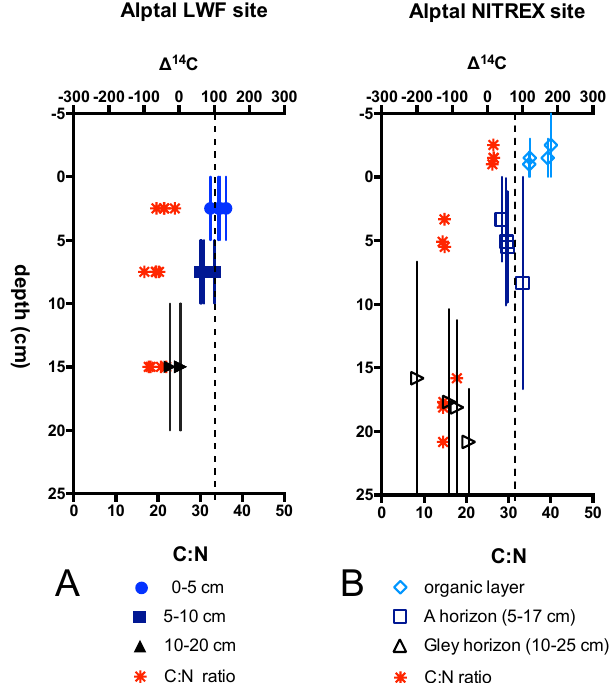
Figure 4. Intra-forest variability (a) four samples each taken from an area of approximate 400m 2 , totaling to 1600m 2 (b) four sam- ples representing micro-topographic end members sorted by hori- zon covering around to 1500m 2 . The vertical bars represent the depth intervals. The dashed line indicates the (cid:49) 14 C signature of the atmosphere at the time of sampling in resp; 1998 (a) and 2002 (b) (Hua et al.,